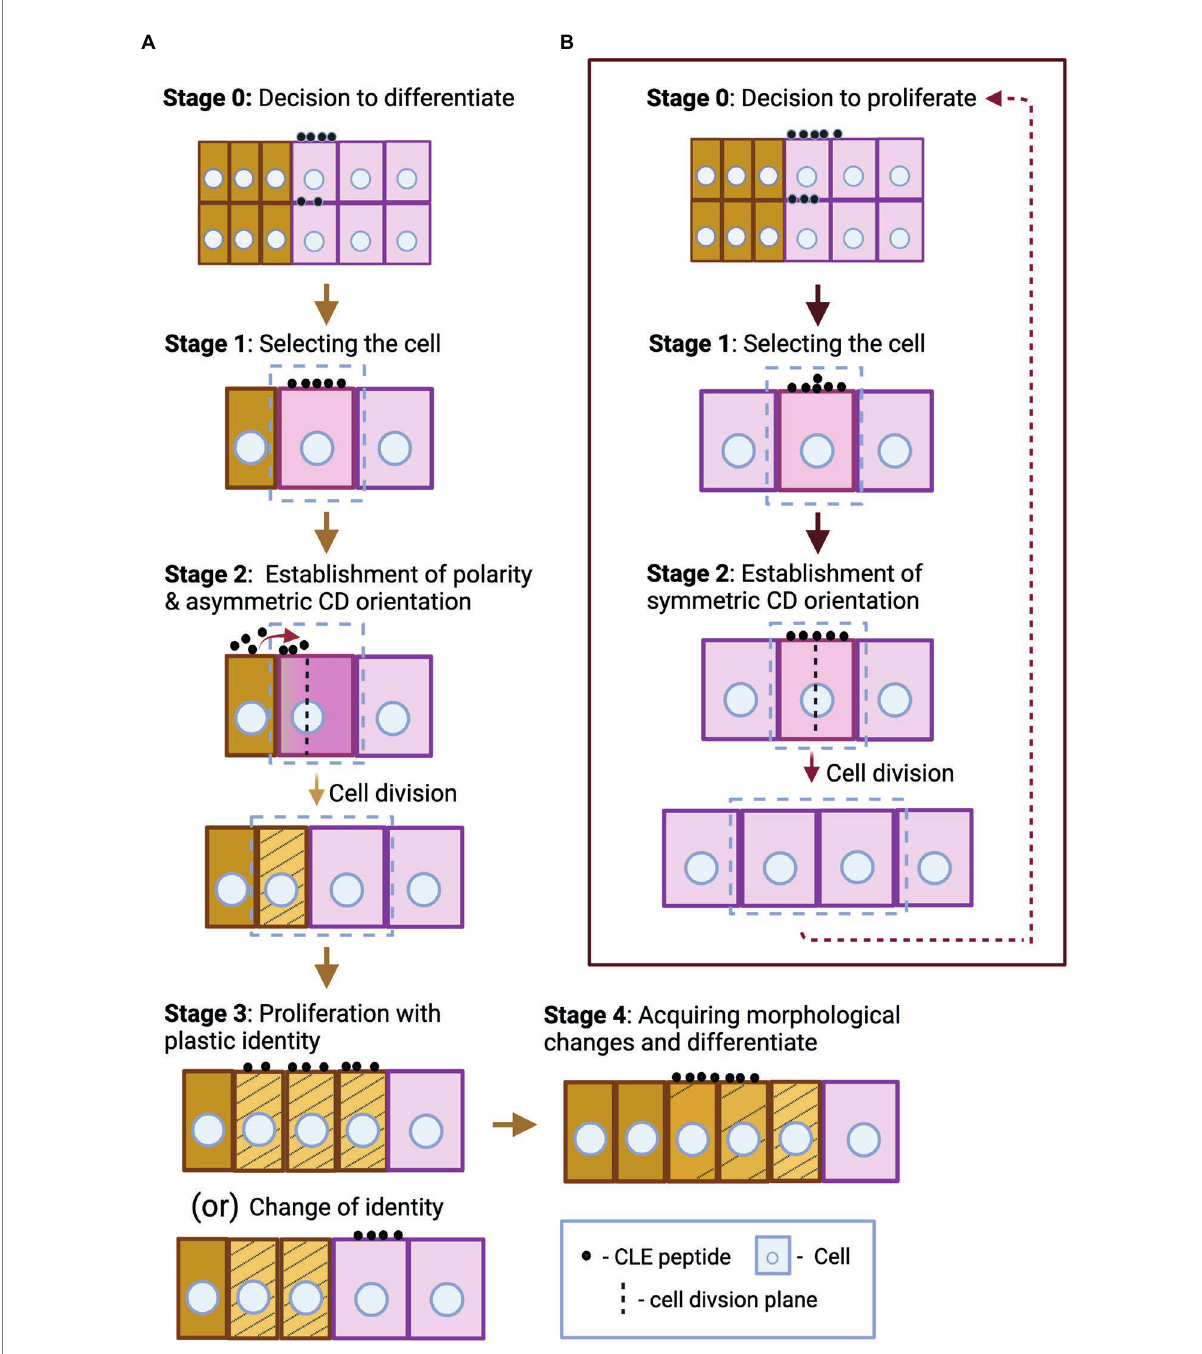
FIGURE 1 Schematic representation of some key aspects of different stages of asymmetric stem cell division and differentiation (A) , and symmetric cell division during proliferation (B) . (A) In stage 0, the CLE peptides that originate from the same or the surrounding cells send the signal to differentiate. Following the signal, the stem cell undergoes differentiation, and this process can be divided into four basic stages. First, the cell to undergo asymmetric formative division is selected (marked by a box)—stage 1. Based on the positional cues offered by neighboring cells through secreted CLE peptides (their origin and direction of diffusion are indicated by red arrow), the cell polarity and the cell division orientation are established. The cell divides producing daughter cells of unequal sizes with distinct identity (represented by striped yellow and pink cells)—stage 2. When the freshly divided stem cells are endowed with plastic identity (represented by stripes), they proliferate with the same plastic identity, or a particular cell (striped yellow) switches its identity to that of the surrounding cell (pink), under certain circumstances—stage 3. The cells further differentiate and reach its destination identity (unstriped yellow) by acquiring several morphological changes over time—stage 4. Stages 3 and 4 may also be regulated by CLE peptides, but the origin and directionality of the CLE peptides regulating stages 0, 3, and 4 are not defined in this figure as these can be case specific. (B) After the decision-making CLE peptides signal to proliferate—stage 0, the stem cells undergo proliferation, and this process comprises of two basic stages. First, the cell to undergo symmetric division is selected—stage 1. Then a symmetric cell division plane is set and the cell divides to form identical daughter cells—stage 2. The stem cells proliferate by continuous repetition of the two cell division stages. CLE peptides can induce or inhibit any of these stages of differentiation and proliferation